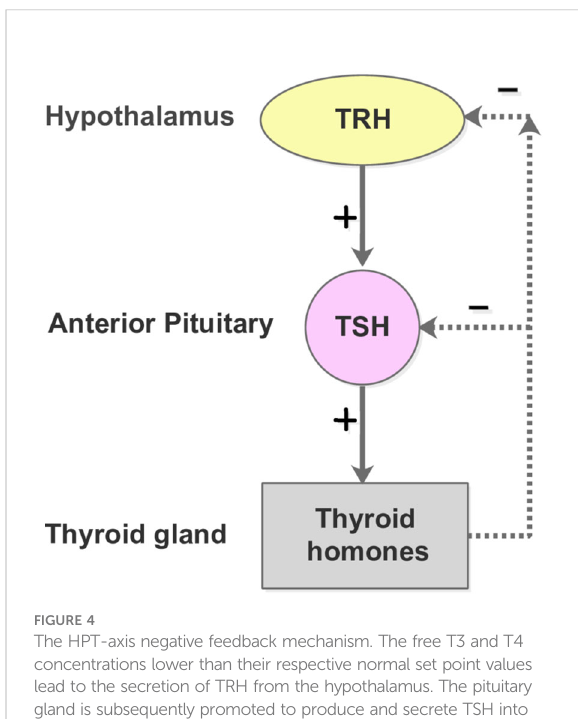
FIGURE 4 The HPT-axis negative feedback mechanism. The free T3 and T4 concentrations lower than their respective normal set point values lead to the secretion of TRH from the hypothalamus. The pituitary gland is subsequently promoted to produce and secrete TSH into the blood, which in turn stimulates the thyroid follicle cells to secrete T3 and T4. In contrast, when the plasma levels of free T3 and T4 are elevated beyond their normal range, the hypothalamus and pitutary gland respond by reducing the secretion of TRH and TSH, which slows down the production of T3 and